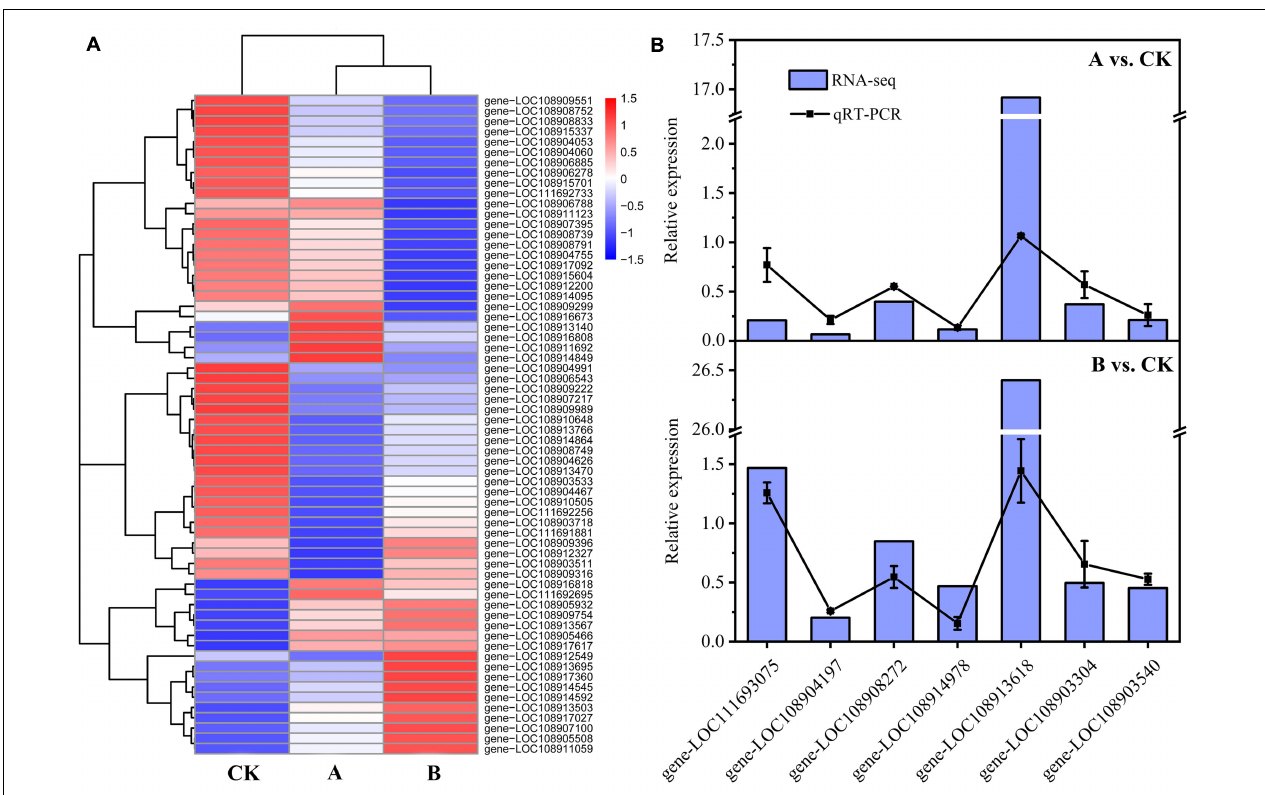
FIGURE 6 | Heat map of TF expression and RT-qPCR validation. (A) Heat map of TF expression. (B) RT-qPCR analyses to confirm expression patterns indicated by RNA-seq analyses. Genes were randomly selected for RT-qPCR. The RT-qPCR results are presented as the mean average of 2 − (cid:49)(cid:49) CT values. The RNA-seq results are presented as the Fold Change. gene-LOC111693075, sugar transporter ERD6-like 4; gene-LOC108904197, probable transaldolase; gene-LOC108908272, cathepsin B-like; gene-LOC108914978, uncharacterized LOC108914978; gene-LOC108913618, uncharacterized LOC108913618; gene-LOC108903304, glutathione S-transferase-like; gene-LOC108903540,